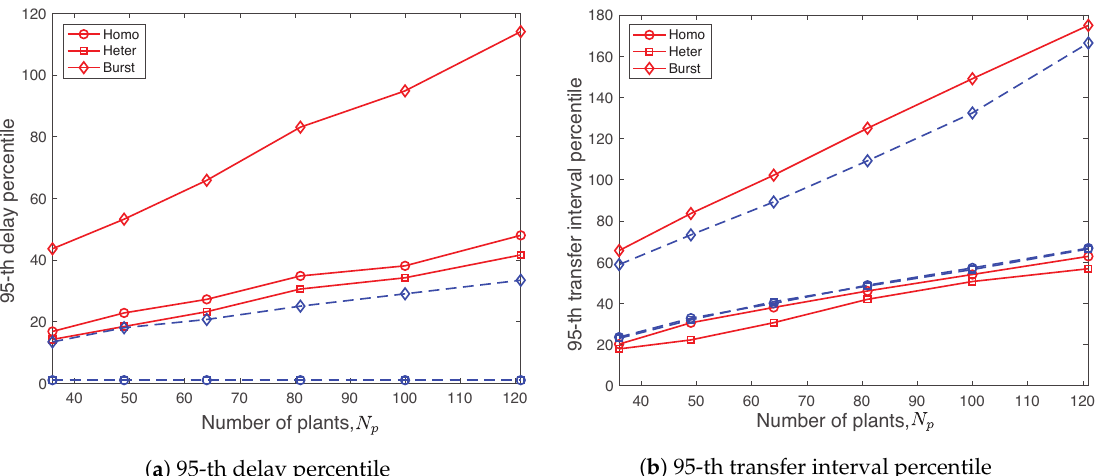
Figure 14. Delay and transfer interval percentiles using R-WSAN and the centralized protocol with homogeneous, heterogeneous, and burst links as a function of different number of plants N p = 36, . . . ,121. R-WSAN provides the significantly lower feedback delay than the one using the centralized protocol. Furthermore, the transfer interval performance of R-WSAN is robust over burst